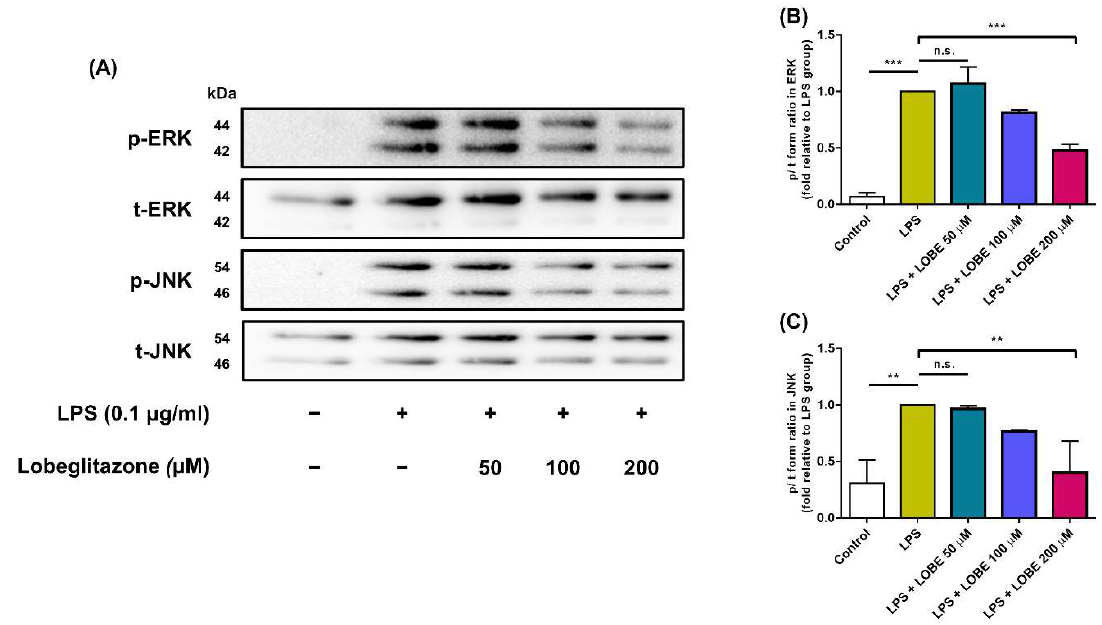
Figure 5. Effect of LOBE on phosphorylation level of extracellular regulatory kinase (ERK) ( A,B ) and c-Jun N terminal kinase (JNK) (A, C ) of mitogen-activated protein kinase (MAPK) signaling pathway in LPS-stimulated BMDMs. BMDMs were pre-treated with or without LOBE for 20 min prior to 0.1 µg/mL of LPS treatment. After LPS stimulation, cells were harvested for Western blot analysis to detect changes in phosphorylation in ERK and JNK signaling. The ratio of band intensity of phosphorylated form over total form was quantified. The p/t volume for LPS group was set to 1-fold, and fold changes were calculated relative to LPS group. Results are the mean ± SD of triplicate experiments: n.s., ** p < 0.01, *** p < 0.001, significant difference as compared to the control group and each group by one-way ANOVA followed by Tukey’s post hoc analysis.